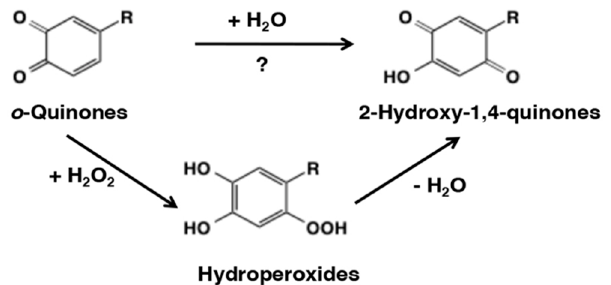
Figure 15. Reaction of o -quinones with hydrogen peroxide leading the production of 2-hydroxy-1,4-quinones [67,68]. Note that the direct addition of water molecule to o -quinone is unlikely to occur.